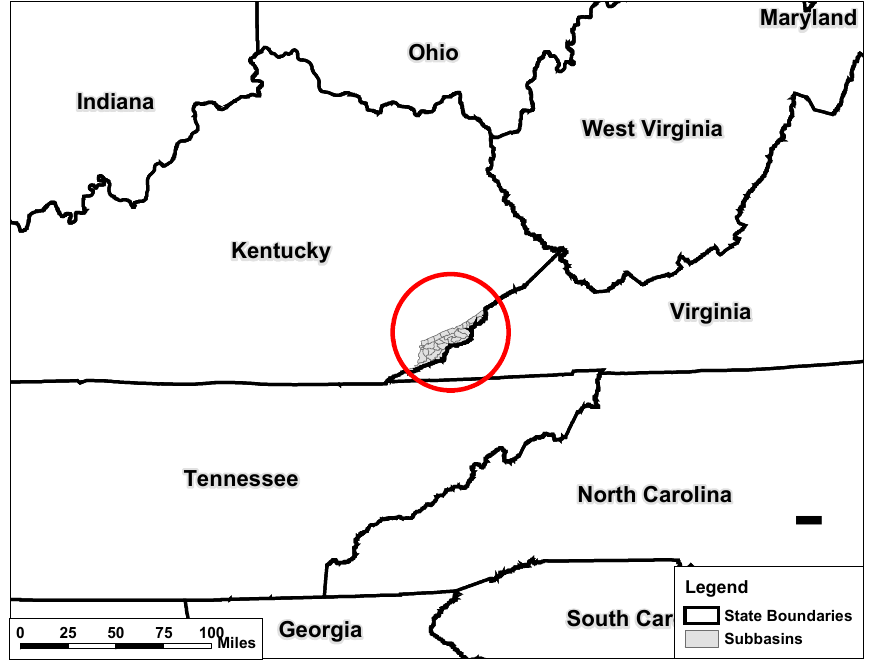
Figure 1. Upper Cumberland basin